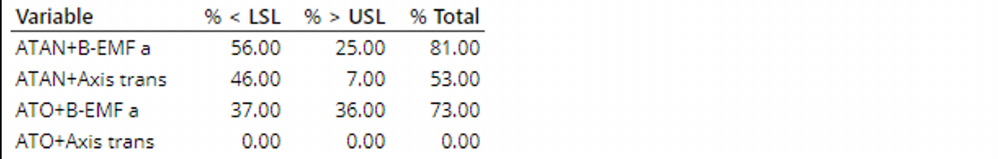
Figure 12. Normal distribution and capability